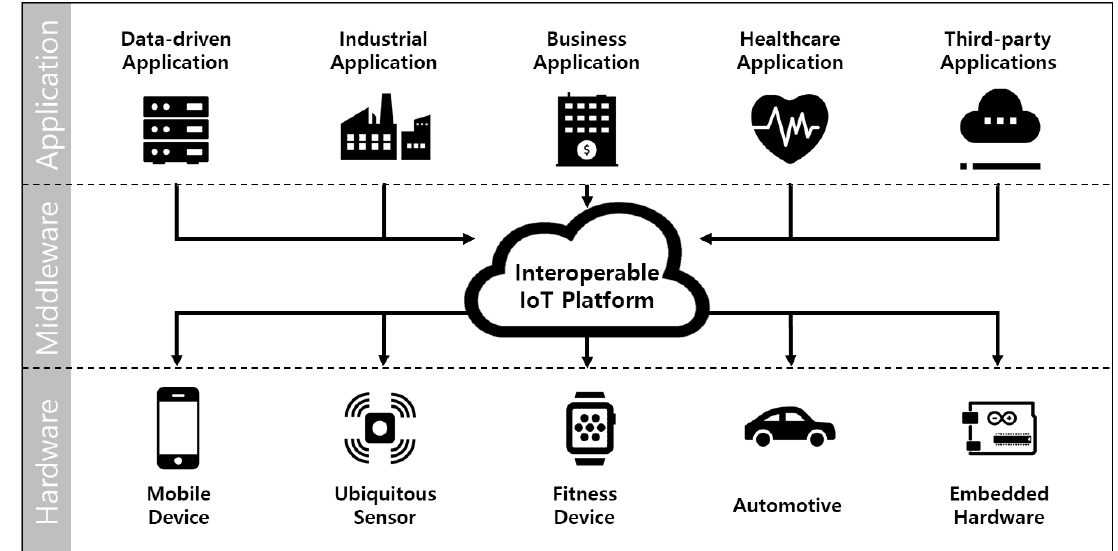
Figure 1. Simple topology for interoperable IoT